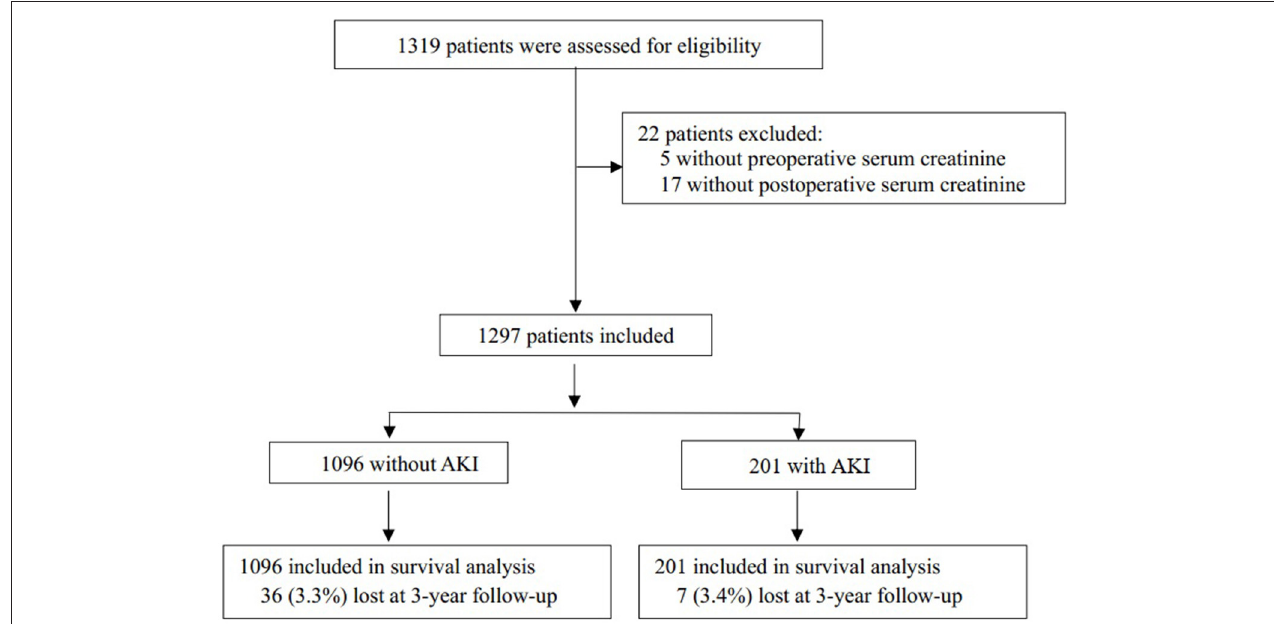
FIGURE 1 | A flowchart of the study. AKI, acute kidney